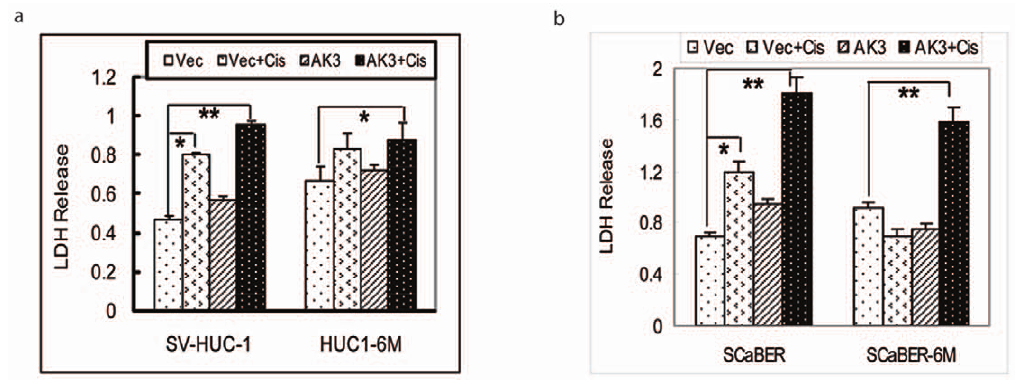
Figure 4. AK3 Induced Release of Lactate Dehyderogenase upon Treatment of Cisplatin. LDH release in SV-HUC-1 (a) and SCaBER (b) cells exposed to CSC vapor in presence of AK3 followed by cisplatin treatment for 48 h. The data are presented as means 6 SD. All experiments were performed in triplicate. Statistical significance is as indicated with * indicates P , 0.05 and ** indicates P , 0.01.